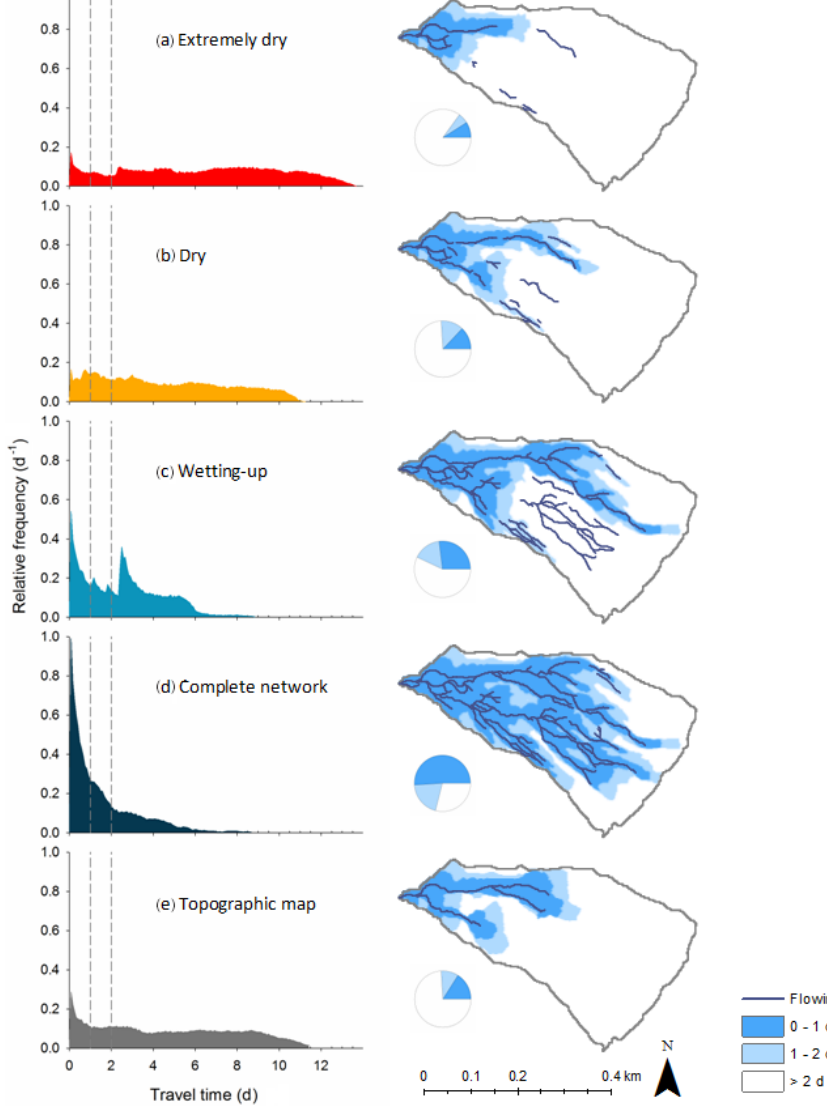
Figure 4. Effects of flowing stream network extension and retraction on the travel time distributions. The left-hand column shows the distributions of travel times ( t t ) to the catchment outlet for the five flowing stream networks. The right-hand column shows the networks themselves as well as the locations in the catchment with travel times ≤ 1 and 1–2d (dark blue and light blue, respectively, corresponding to the fractions of catchment area shown in the pie charts). Travel times were calculated assuming a subsurface velocity ( v h ) of 5 × 10 − 4 ms − 1 and a surface velocity ( v s ) of 0.5ms − 1 . See Table 2 for the main descriptive statistics of the travel time distributions. Under wetter conditions, more of the catchment area lies close to flowing streams; thus, travel times are shorter and their distribution is more